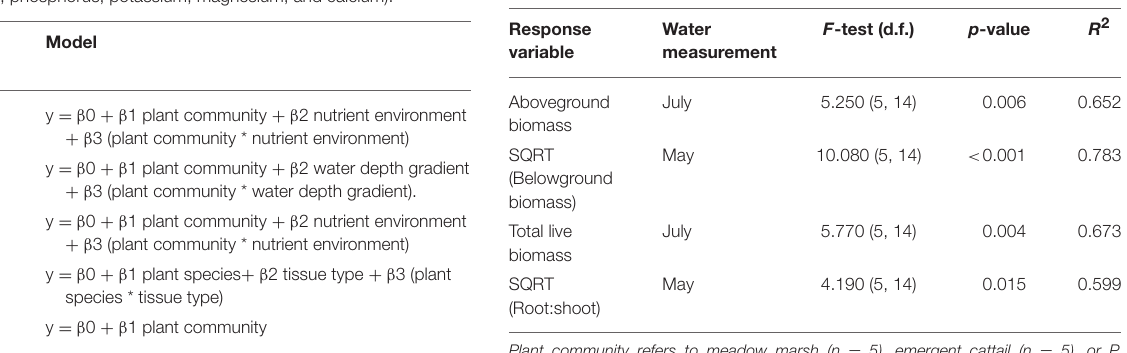
TABLE 4 | Results of general linear model fit tests for biomass response variables, as predicted by y = β 0 + β 1 plant community + β 2 water depth gradient + β 3 (plant community * water depth